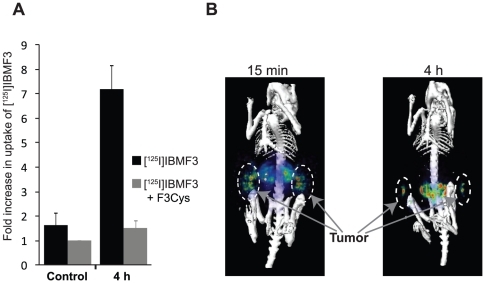

In vitro cell uptake and in vivo SPECT imaging with [125I]IBMF3.(A) MDA-MB-435 cells were incubated with [125I]IBMF3 either alone or in the presence of F3Cys for 0 h or 4 h and uptake of [125I]IBMF3 was measured. To determine non-specific binding cells in control group were treated with [125I]IBMF3, the media removed immediately after addition of the radioligand and processed as for the experimental group. All experiments were performed in triplicate and repeated at least thrice. The data presented here is an average of radioactivity counts per well +/− SD. (B) Mice bearing MDA-MB-435 xenografts were injected i.v. via the tail vein with [125I]IBMF3 and animals were serially imaged post injection. Representative images obtained at 15 min and 4 h post-injection are shown.